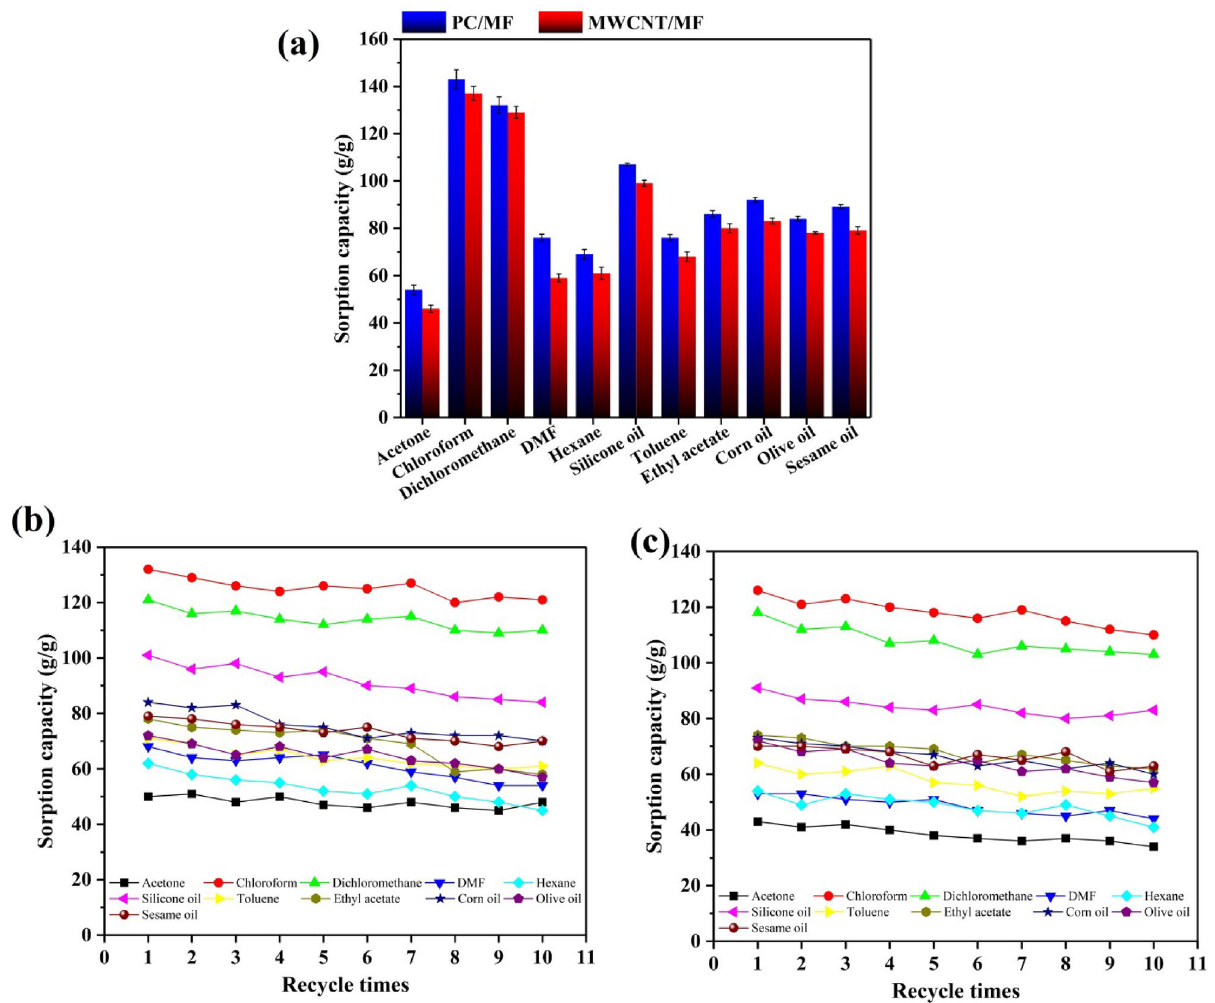
Figure 9. ( a ) The sorption capacity of PC/MF and MWCNT/MF and the sorption capacities of recyclable superhydrophobic/superoleophilic ( b ) PC/MF and ( c ) MWCNT/MF for selected oils and organic solvents in ten adsorption–desorption